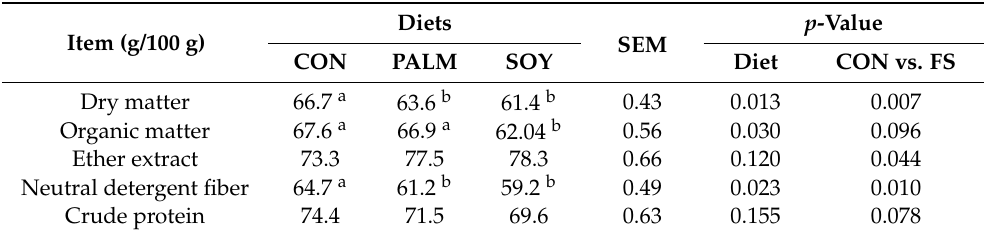
Table 3. Apparent digestibility of nutrients in lambs fed diets with fat supplements (FS; 50 g/kg) of prilled palm oil (PALM), soybean oil (SOY), or without fat supplementation